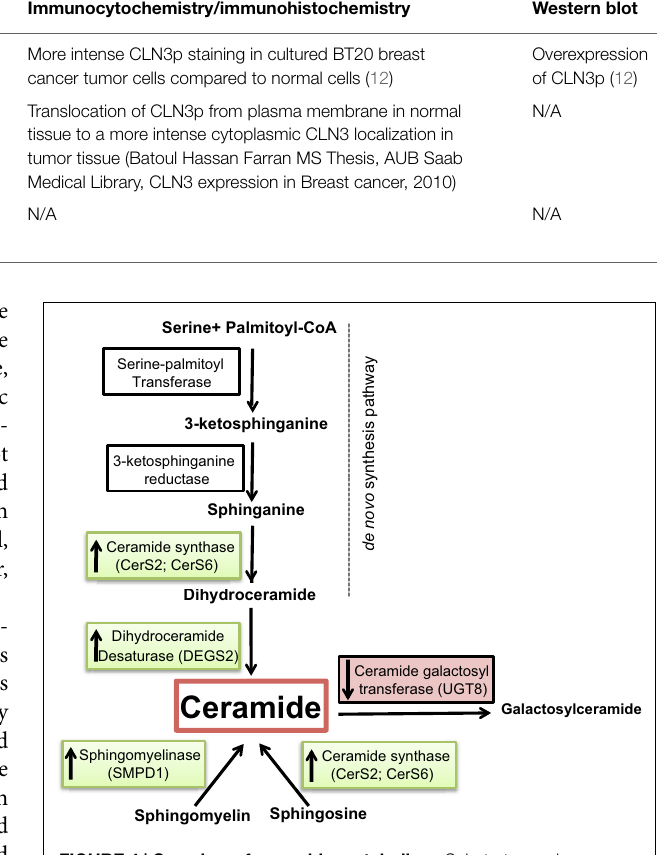
FIGURE 4 | Overview of ceramide metabolism . Substrates and intermediates in the metabolism of ceramide are schematically shown and the respective enzyme names are stated next to the arrows. Enzymes overexpressed in tumor vs. normal samples are shown in green, and the ones underexpressed are shown in